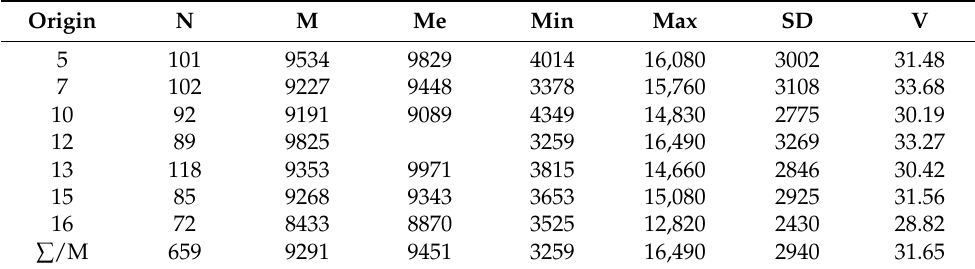
Table 4. Characteristics of modulus of elasticity under static bending Eg 12 (MOE) (MPa) of diverse ge- netic origins (N—Number of groups; M—Average; Me—Median; Min—Minimum; Max—Maximum; SD—Standard deviation; V—Coefficient of variation).